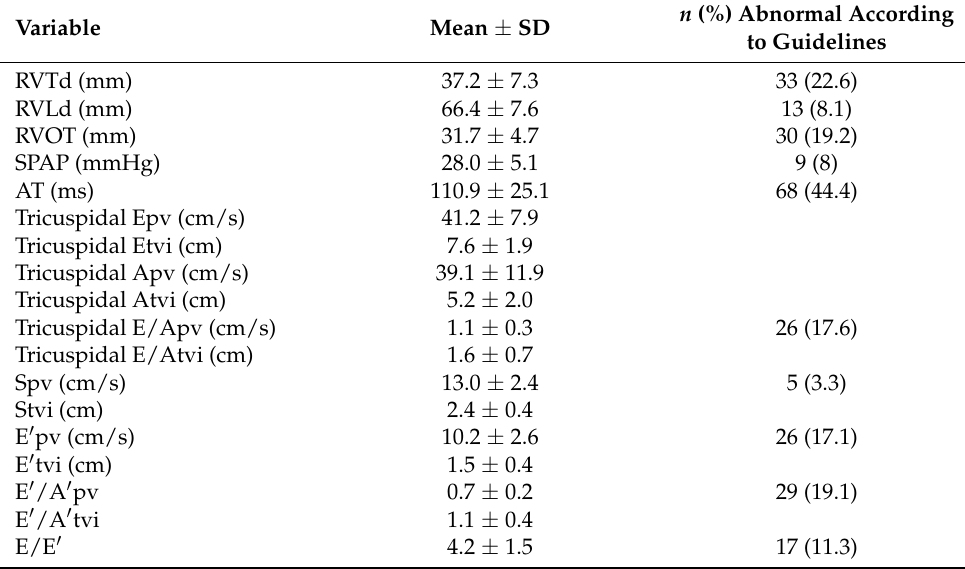
Table 3. Echo-based right ventricular structural and functional data in the total population ( n =